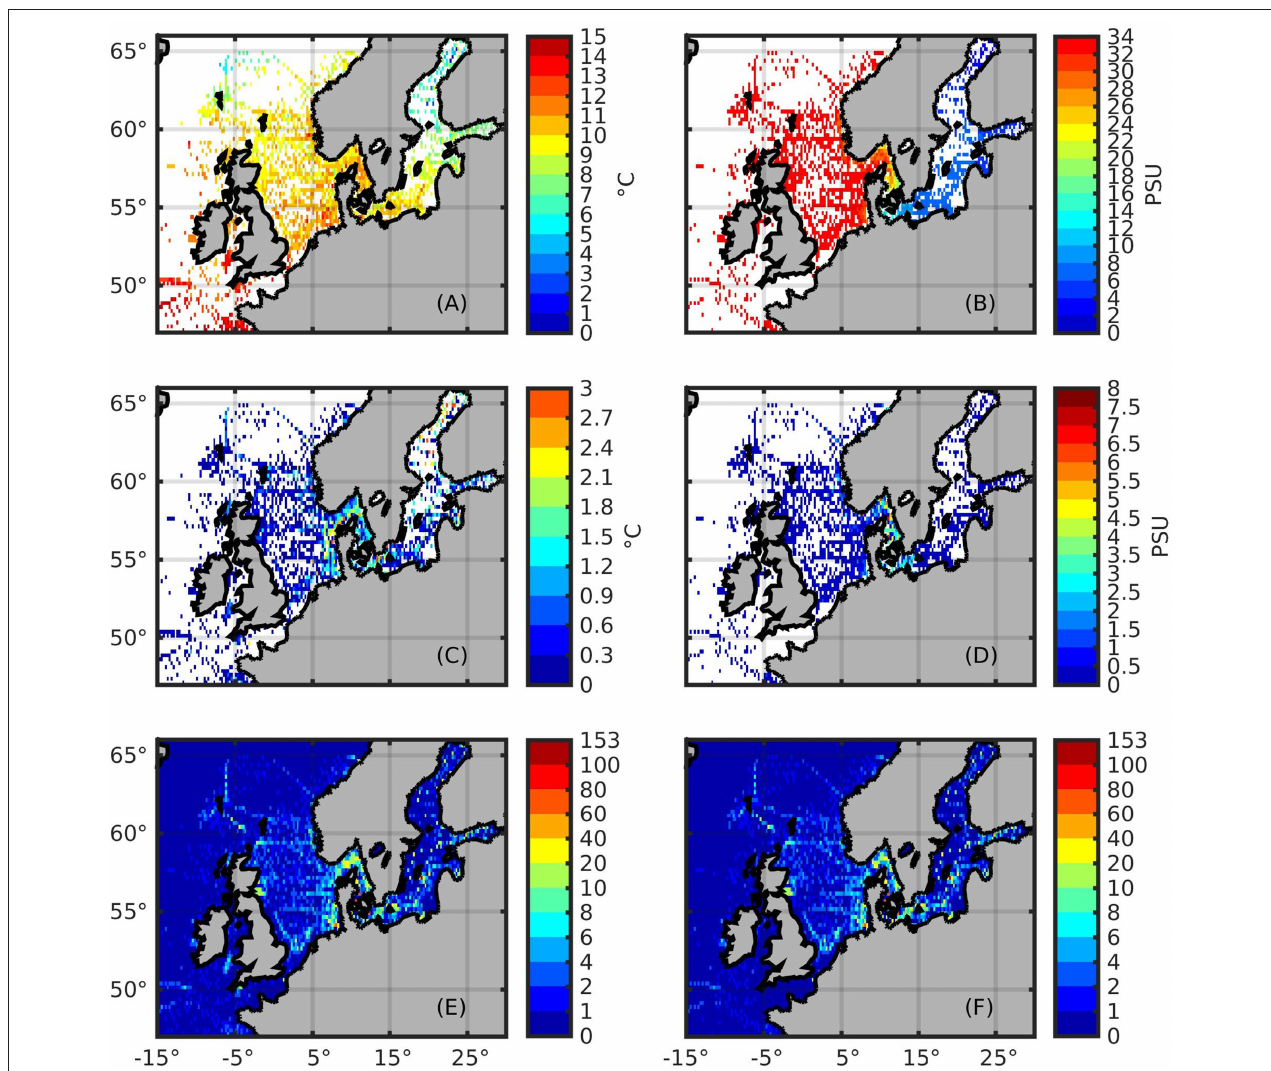
FIGURE 7 | Sea surface: annual mean values of both BNSChydr parameters [temperature: (A) and salinity: (B) ] for the year 2000, together with the respective standard deviation (C,D) and the number of observations (E,F) .